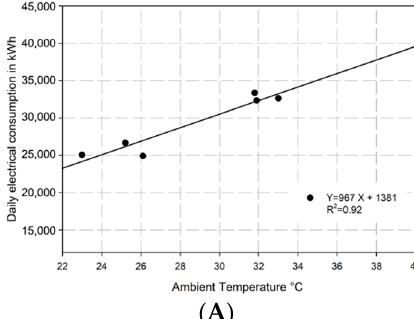
Figure 6. Different linear relationships between ambient temperature and measured electrical con- sumption in the UJ campus for Mondays in different intervals A and E from Table 2. ( A ) Mondays in spring term from 25 March 2019 to 29 April 2019 (Interval A) and ( B ) Mondays in fall academic term from 2 September 2019 to 11 November 2019 (Interval E).